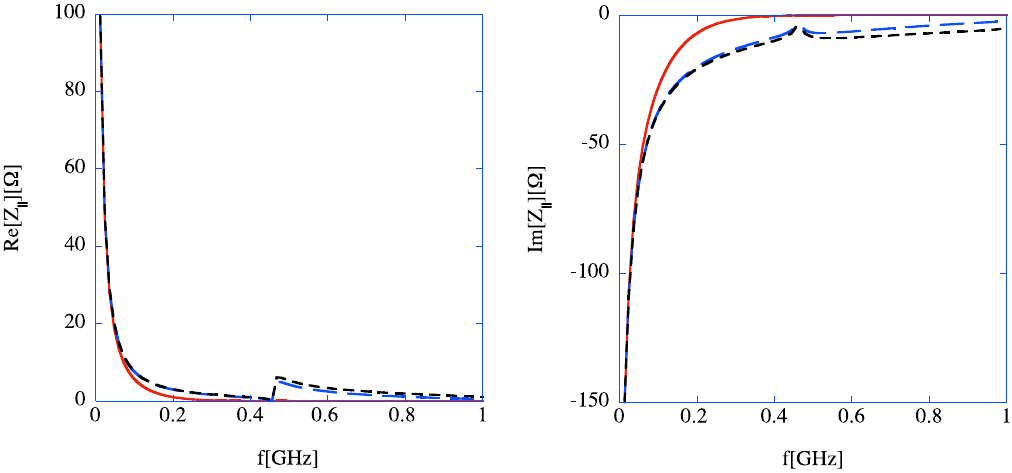
FIG. 4. (Color) The dependence of longitudinal impedance on Lorentz factor (cid:6) . We assume the chamber with the large radius of a (cid:4) 250 mm . The red, blue, and black curves represent (cid:6) (cid:4) 1 : 2 , (cid:6) (cid:4) 4 , and (cid:6) (cid:4) 1000 cases, respectively. The left and the right figures show the real and the imaginary parts of longitudinal impedance, respectively. The impedance for a nonrelativistic beam with (cid:6) of 1 : 2 is indeed smaller than for a relativistic beam with gamma larger than several.